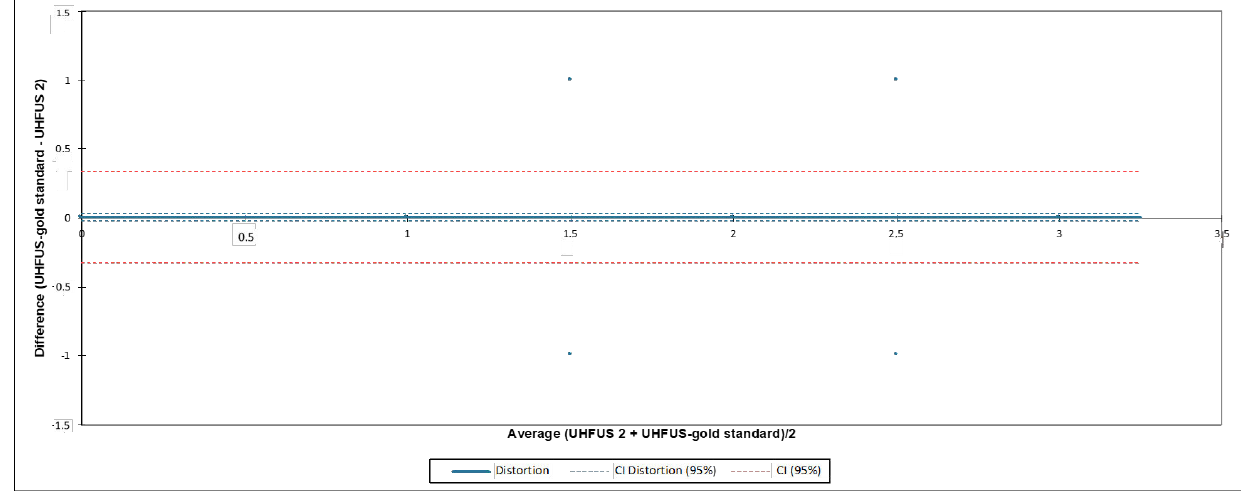
Figure 3. Bland-Altman test evaluating the agreement between the second reader (UHFUS 2) and gold standard examiner (UHFUS-gold standard). The 95% confidence interval (CI) of the distortion was ( − 0.019; 0.031).